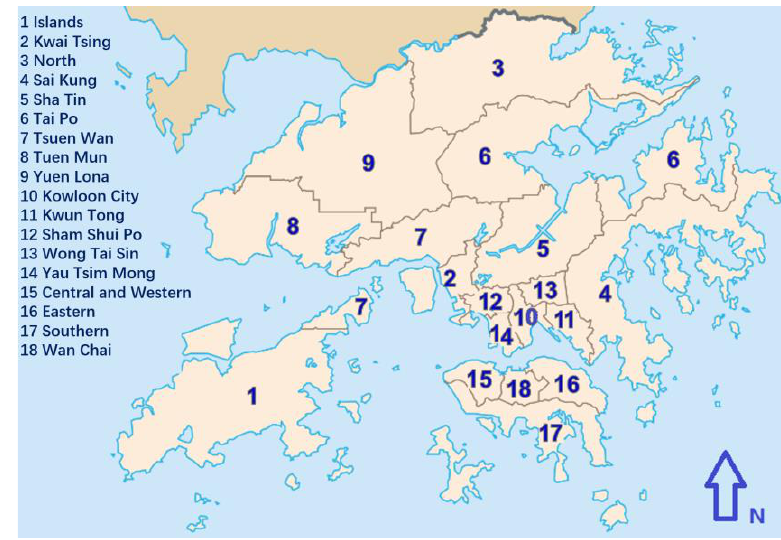
Figure 1. Hong Kong’s 18 districts .